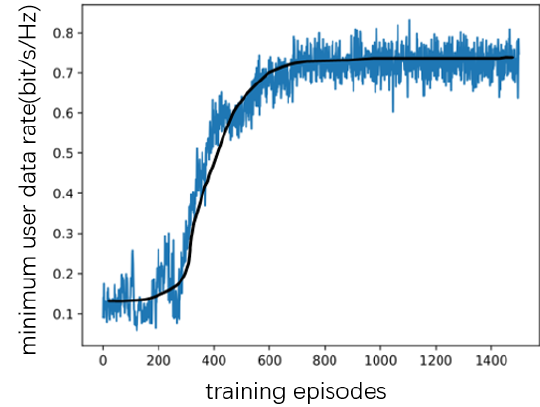
Figure 3. RIS = 20.